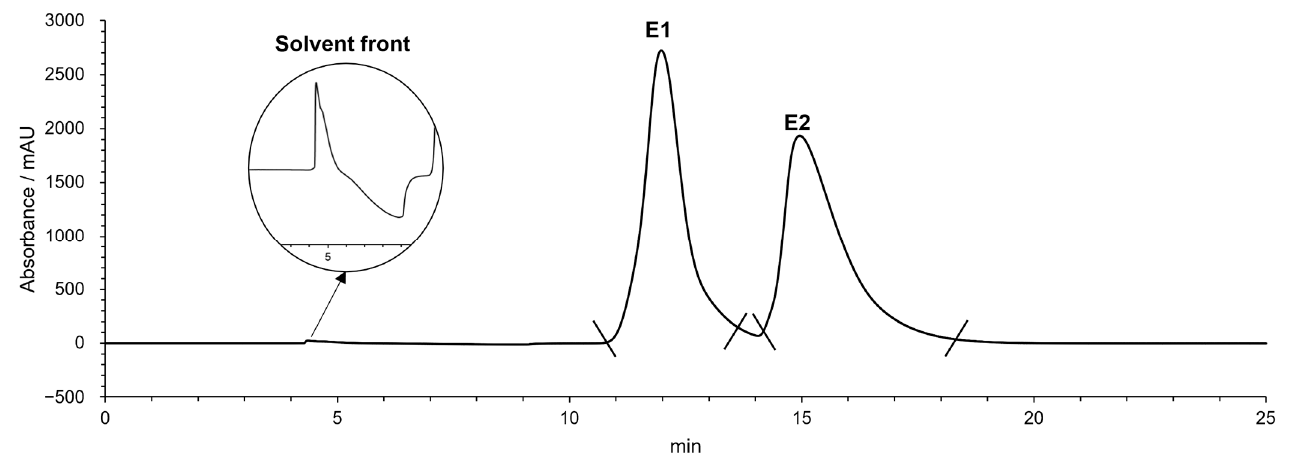
Figure 2. Chromatogram of semi-preparative separation of the enantiomers of MDPV. Chromatographic conditions: tris-3,5-dimethylphenylcarbamate amylose homemade column; mobile phase: Hex:EtOH:DEA (97:3:0.1 v / v / v ); flow rate: 1.5 mL/min; UV detection: 254